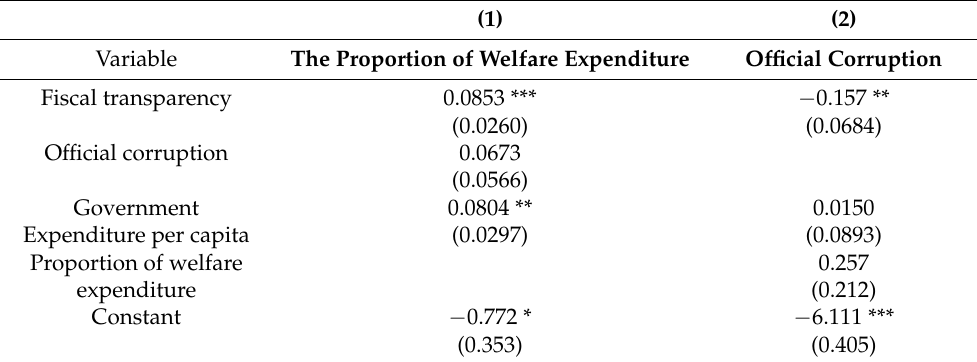
Table 6. Test of the mechanism of fiscal transparency affecting the quality of public services in 12 coastal provinces and cities of